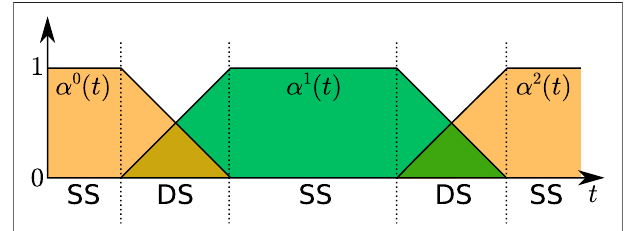
FIGURE6| Thepro fi leoffunctions α j ( t )usedtoexpress thecenterofthe movingconstraintregion,foracase with F =2.Inthisexample, α 0 ( t )relatesthe center of the moving constraint to the position of the current support foot, while α 1 ( t ) and α 2 ( t ) relate it to the position of two predicted